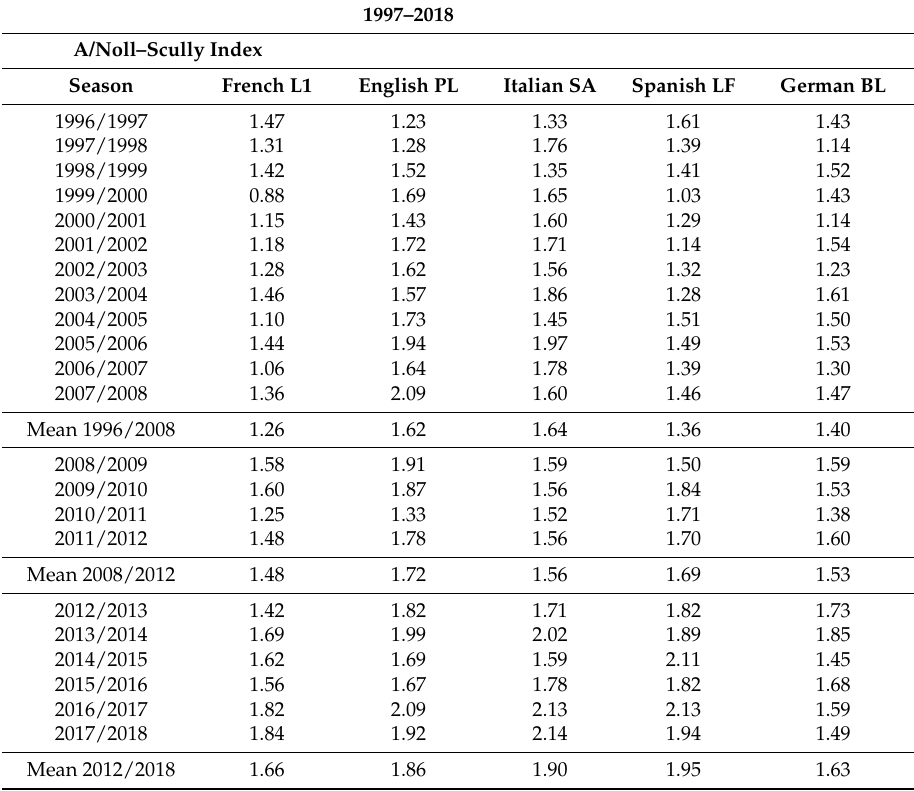
Table 2. The competitive balance in five major European football